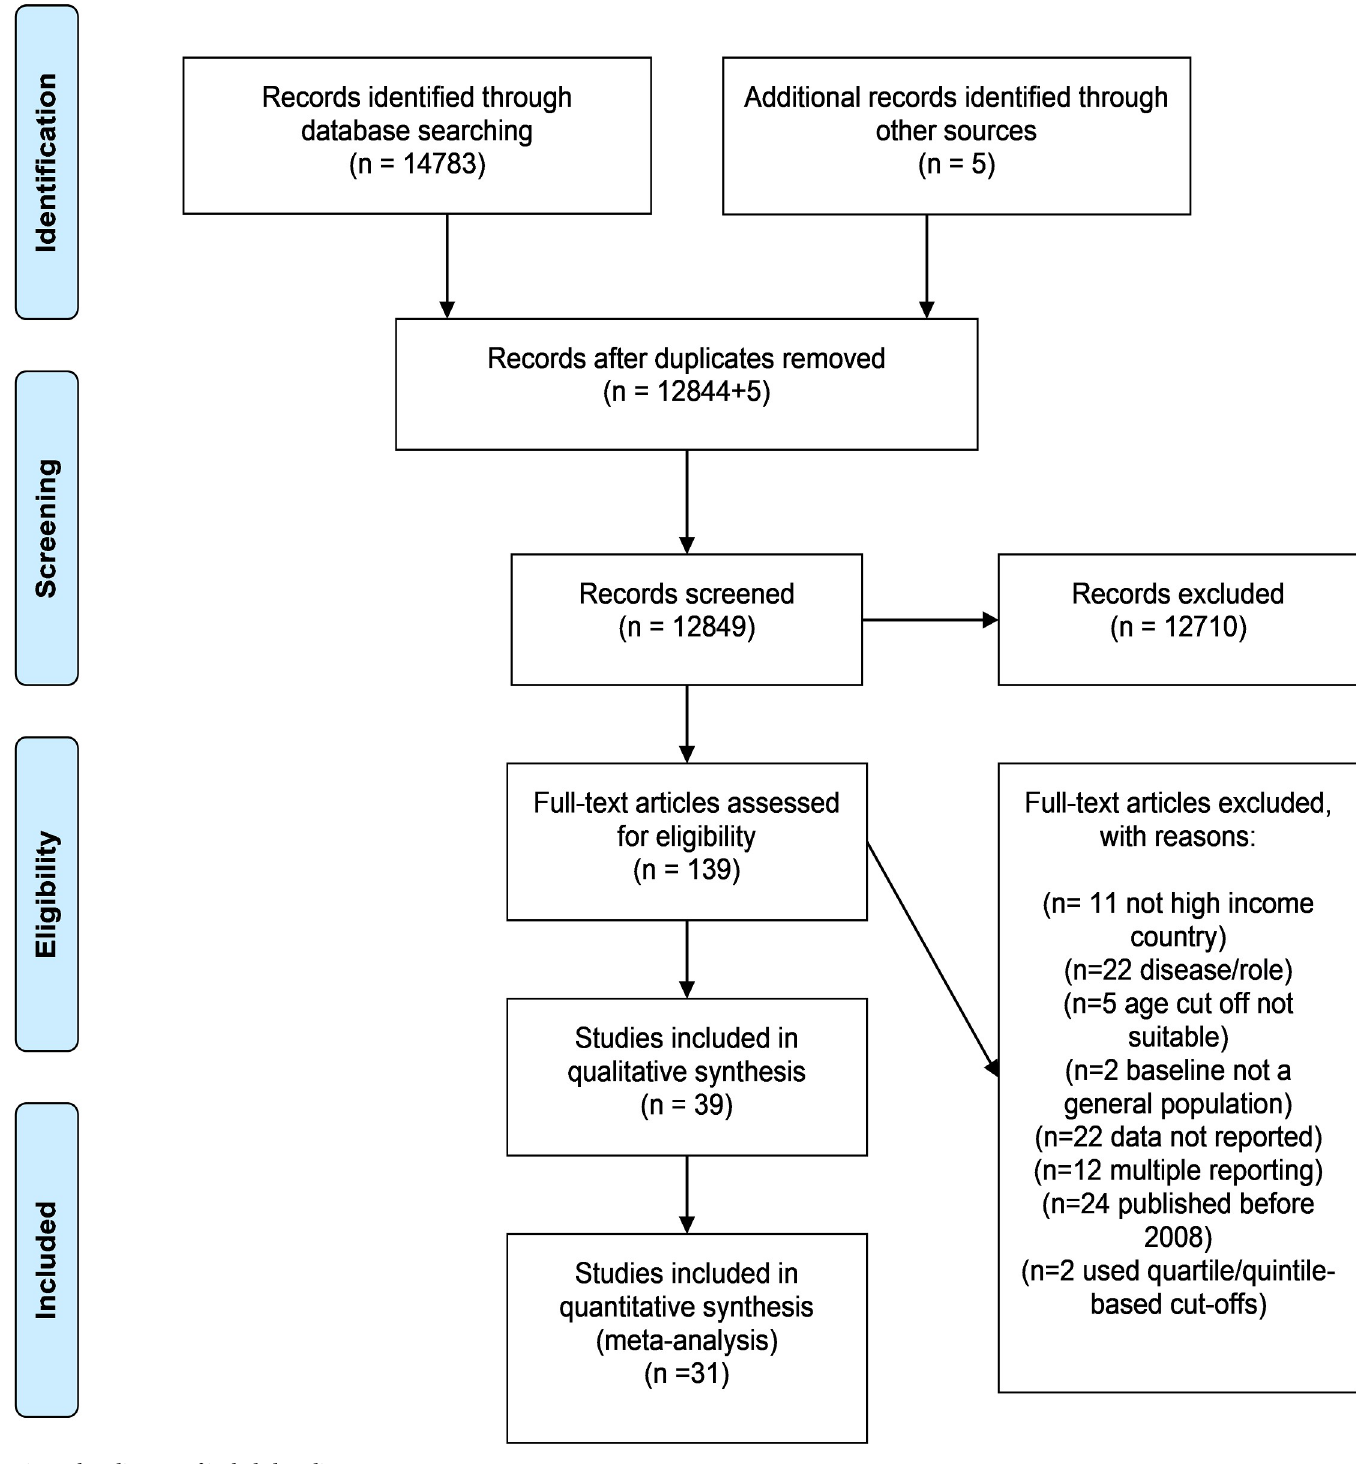
Fig 1. Flow diagram of included studies.